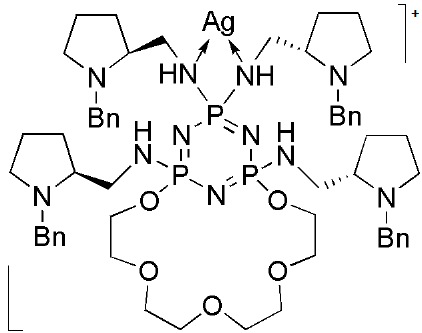
Figure 2. 1 H NMR spectra in acetonitrile solutions for uncomplexed ligand L-( a ) and after adding silver ions with the Ag:L molar ratio 1:1 and 2:1-spectrum ( b ) and ( c ). The second silver ion is bound by the endocyclic nitrogen atom from the cyclotriphosphazene ring. The method of binding two silver ions through ligand L is shown in Scheme 5.